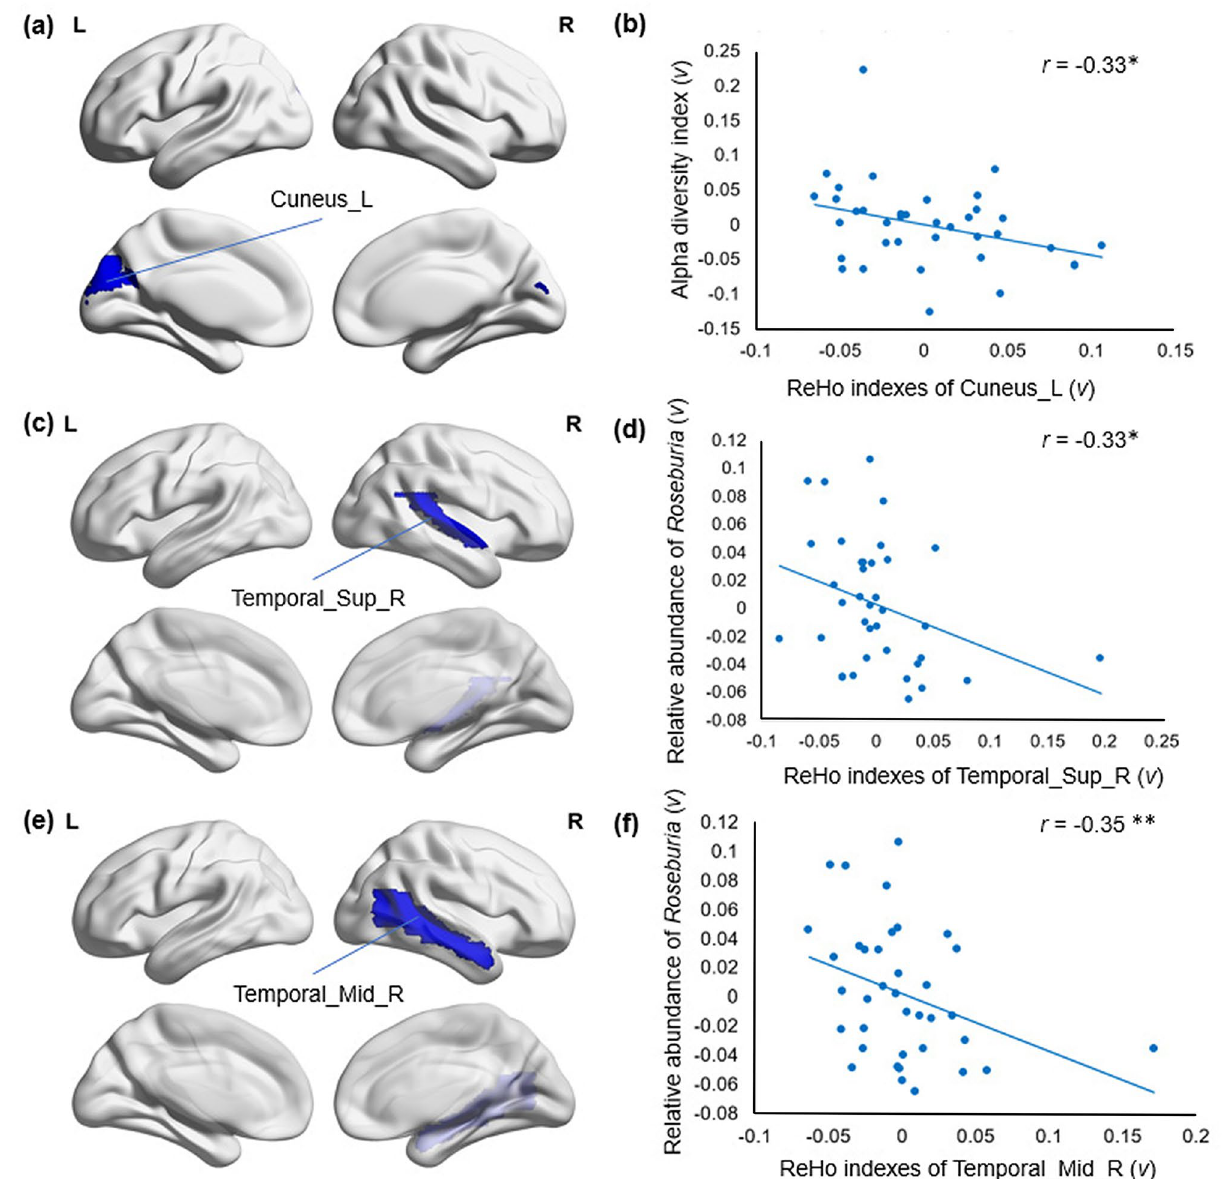
Figure 4. Relative abundance of Roseburia in SZ patients showed strong negative correlations with ReHo indexes. ( a ) Cuneus_L showed significantly decreased ReHo indexes in SZ compared with the NCs ( p < 0.05). ( b ) The residuals of the ReHo indexes in Cuneus_L were significantly negatively correlated with the residuals of the relative abundance of Roseburia in SZ. ( c ) Temporal_Sup_R showed significantly decreased ReHo indexes in SZ compared with the NCs ( p < 0.05). ( d ) The residuals of the ReHo indexes in Temporal_Sup_R were significantly negatively correlated with the residuals of the relative abundance of Roseburia in SZ. ( e ) Temporal_Mid_R showed significantly decreased ReHo indexes in the SZ compared with the NCs ( p < 0.05). ( f ) The residuals of ReHo indexes in Temporal_Mid_R were significantly negatively correlated with the residuals of the relative abundance of Roseburia in SZ. Sup: superior; Inf: inferior; L: left hemisphere; R: right hemisphere. ** p < 0.05, FDR corrected, * p = 0.05, FDR corrected. Figure was generated by a brain network visualization tool of “BrainNet viewer” (Version 1.7, https:// www. nitrc. org/ proje cts/ bnv/), based on MATLAB (Version